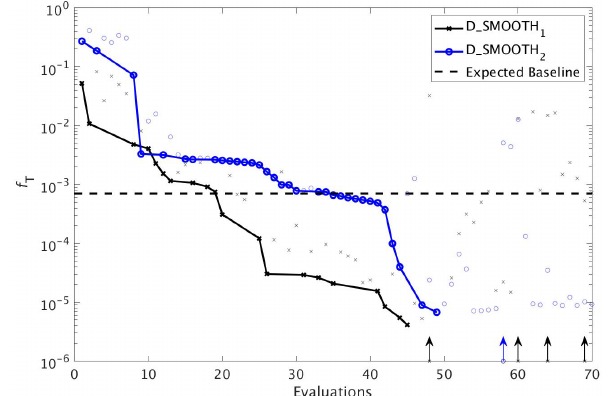
Figure 8. The reduction in global misfit of MOPS to the twin MOPS-ref observations by DFO-LS for the experiments D_SMOOTH 1 (black line with crosses) and D_SMOOTH 2 (blue line with circles). Also plotted is the baseline misfit (horizontal black dashed line). Vertical arrows indicate a soft restart, coloured and marked according to each experiment. Note that every MOPS evaluation has been plotted with a small marker; however, only MOPS evaluations which resulted in a lower misfit than previously seen in each optimisation experiment have been plotted with a solid